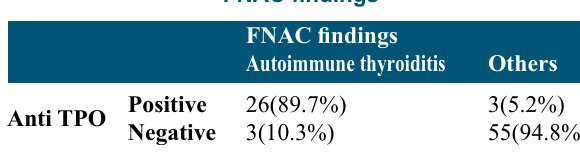
Table 4: Correlation of Anti TPO antibodies and FNAC ndings